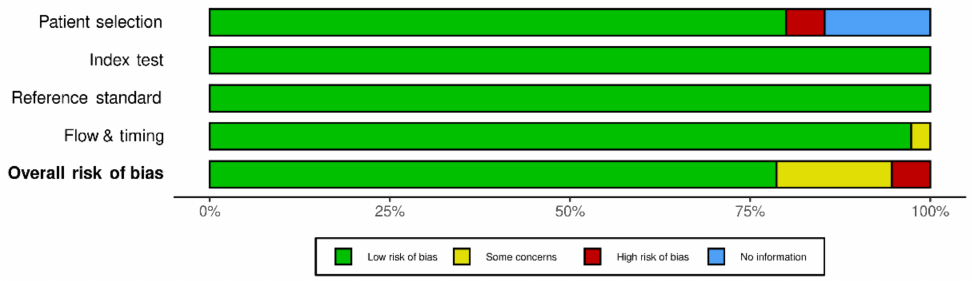
Figure 2. Quality assessment (Methodological quality summary graph.) of the 75 included studies using the tool of Quality Assessment of Diagnostic Accuracy Studies-2